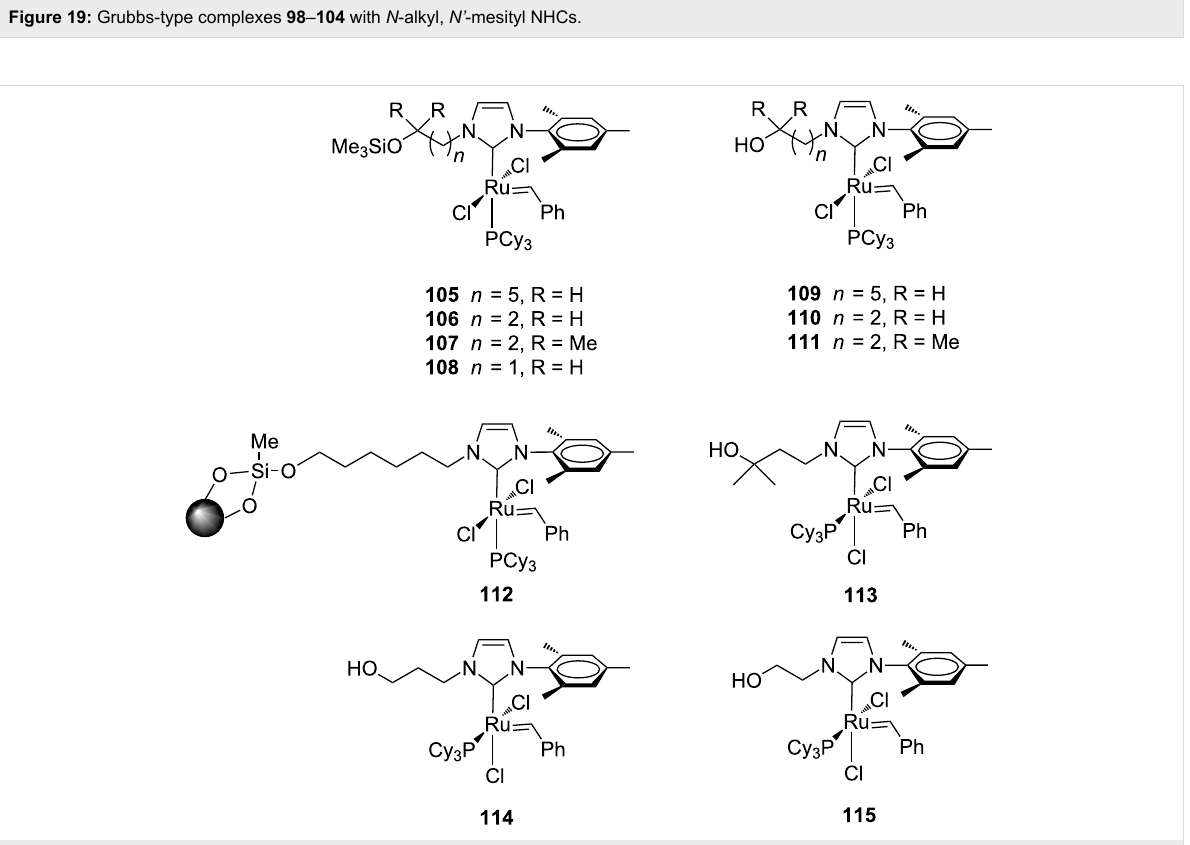
Figure 20: Grubbs-type complexes 105 – 115 with N -alkyl, N’ -mesityl